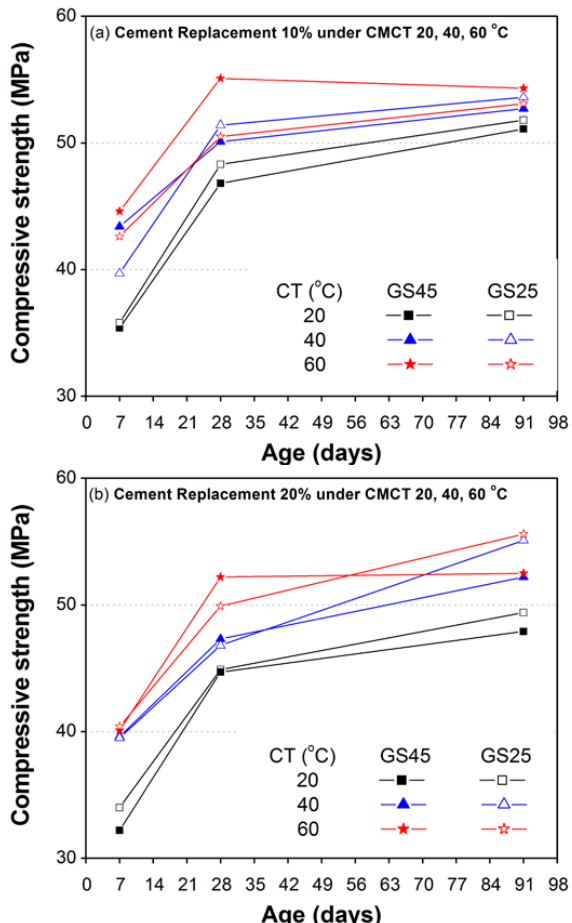
Figure 9. Effect of the fineness of GS on compressive strength of mortar according to aging and curing temperature for: ( a ) 10% replacement with cement; ( b ) 20% replacement with cement. temperature for: ( a ) 10% replacement with cement; ( b ) 20% replacement with